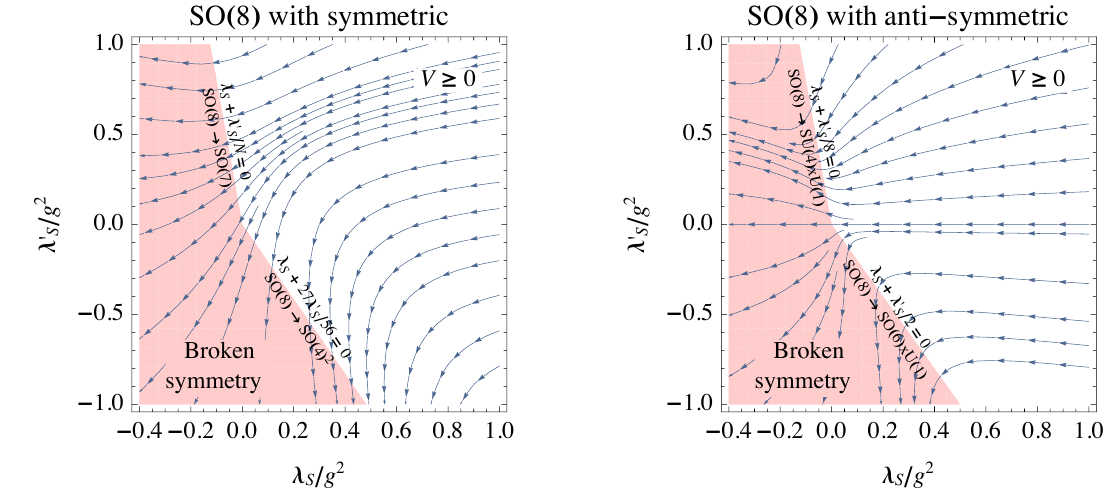
Figure 4 . Coleman-Weinberg symmetry-breaking patterns for a SO( N ) gauge theory. The RGE (cid:13)ow towards low energy of its quartics (cid:21) S and (cid:21) 0 can enter both instability conditions, leading to S the two di(cid:11)erent breaking patterns discussed in the